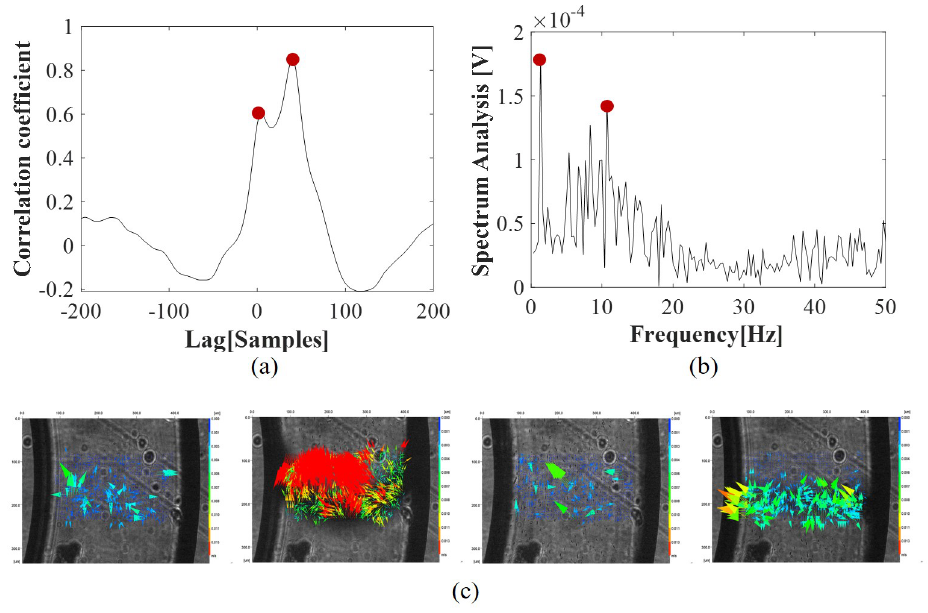
Figure 3. Optical signals processing of { ph 1, ph 2 } in G-320 for the experiment with an input flow rate F = 0.3 mL/min. ( a ) an example of the cross-correlation function for the computation of the slug velocity; ( b ) an example of the spectrum of the signal { ph 2 } for the computation of the slug frequency. In both plots, the two higher peaks are highlighted with red dots; ( c ) a sequence of frames related to a slug passage analyzed by Digital Particle Image Velocimetry